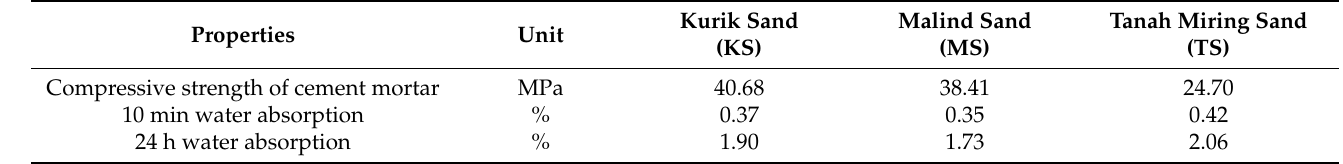
Table 3. Compressive strength and water absorption of cement mortar.